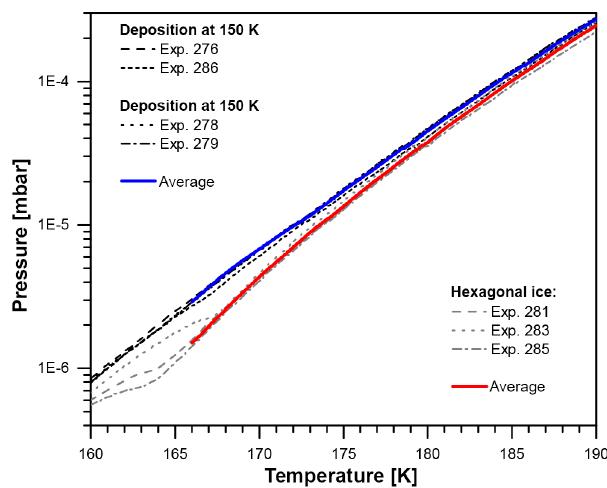
Figure B2. Vapor pressure between 160 and 190K after deposition at 100 and 150K (black lines, four runs) and after the crystallization of hexagonal ice from liquid water at 260K (gray lines, three runs). The solid blue and red lines represent calculated mean values for deposition at 100 and 150K and hexagonal ice,